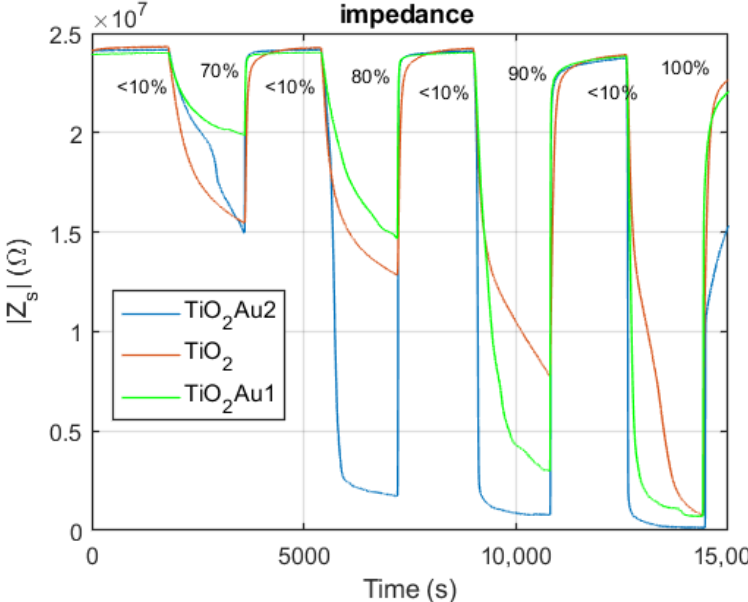
Figure 16. Dynamical response of the TiO 2 (red line), TiO 2 Au1 (green line), and TiO 2 Au2 (blue line) sensing films to increasing RH pulses. The plot shows the measured sensing-film impedance magnitude |Z s | versus time in presence of RH pulses (30 min phases at different RH in the range 70–100% followed by 30 min 0% RH phases).